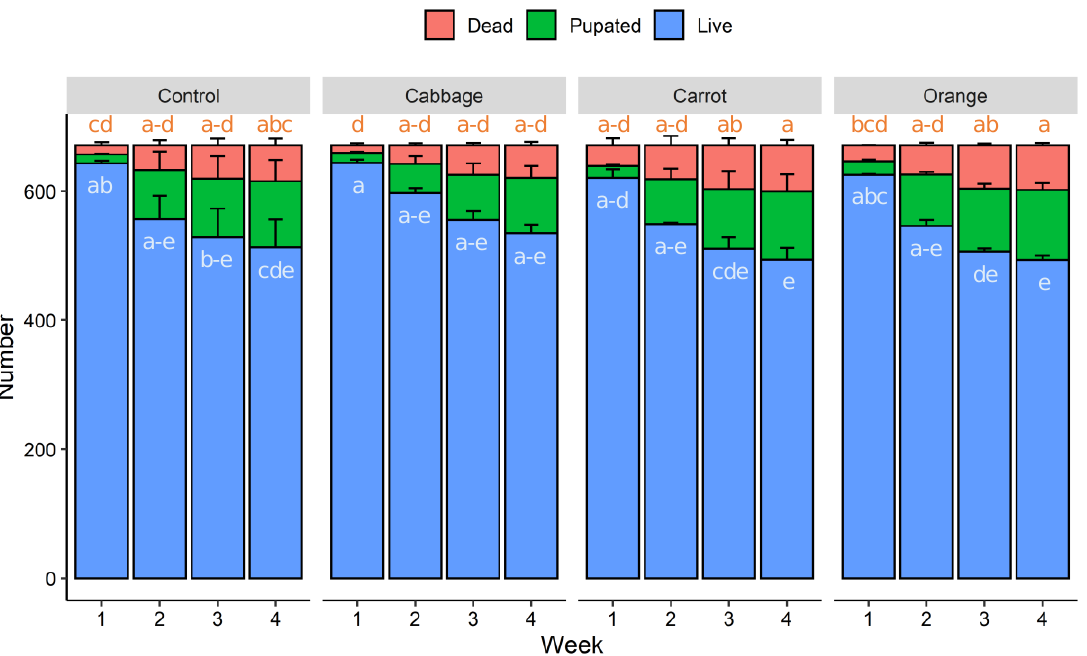
Figure 1. Number of dead, pupated, and live mealworm larvae fed on different diets over four weeks. Numbers of dead or live mealworm larvae sharing no common letters differ significantly ( p < 0.05). No significant difference was found in the numbers of pupated mealworm larvae.